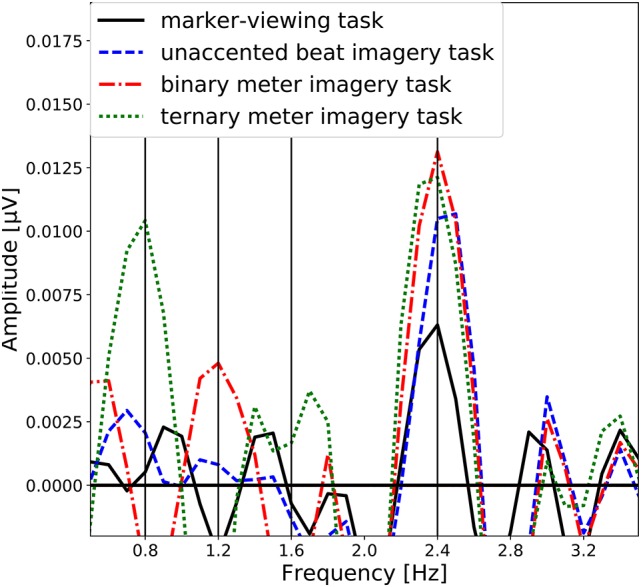
Group-level average of the EEG spectral amplitudes averaged across all scalp electrodes. The EEG spectral amplitudes obtained in the marker-viewing task, the unaccented beat imagery task, the binary meter imagery task, and the ternary meter imagery task are shown in black line, blue dashed line, red dashdot line, and green dotted line, respectively. The vertical lines represent the target frequencies.